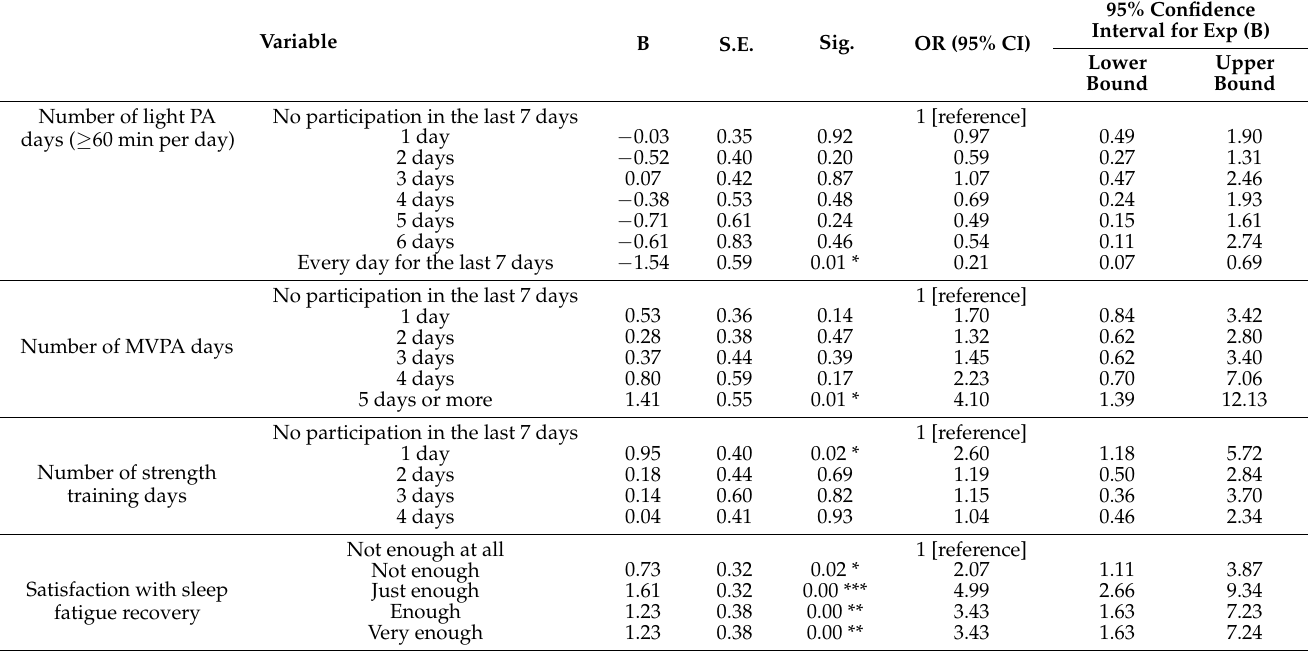
Table 2. Multinomial logistic regression of risk factors related to smartphone dependency. ( n =